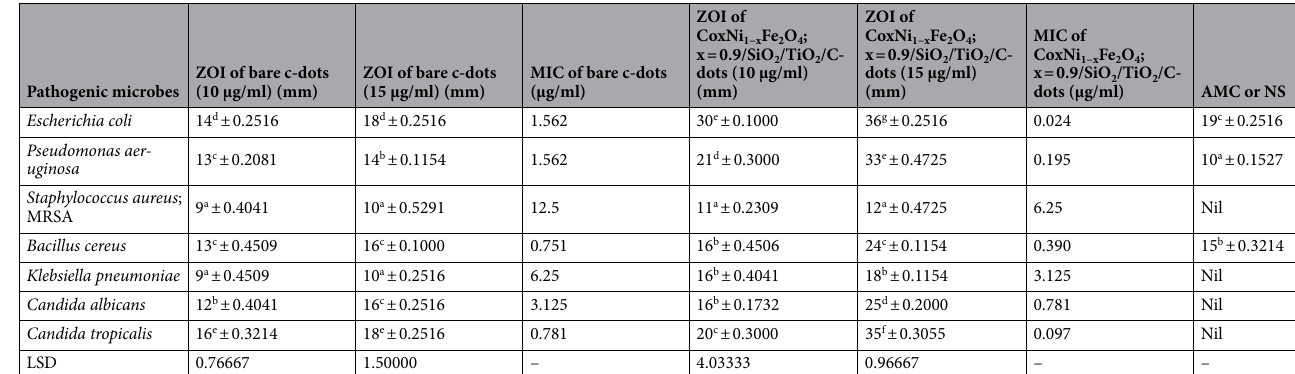
Table 1. Antimicrobial activities of bare C-dots and Co x Ni 1−x Fe 2 O 4 ; x = 0.9/SiO 2 /TiO 2 /C-dots nanocomposite, against multi-drug-resistant (MDR) bacteria and pathogenic Candida species , measured as ZOI (mm) and MIC (μg/ml). Values are presented as means ± SD (n = 3). Data within the groups were analyzed using one-way analysis of variance (ANOVA) followed by superscript letters (a–g) Duncan’s multiple range test (DMRT), LSD least significant difference. Nil means that no ZOI was measured. AMC amoxicillin/clavulanic acid (standard antibacterial agent). NS Nystatin (standard antifungal